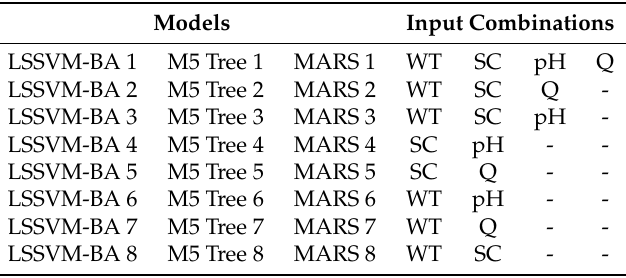
Table 4. The input combinations used for the development of prediction